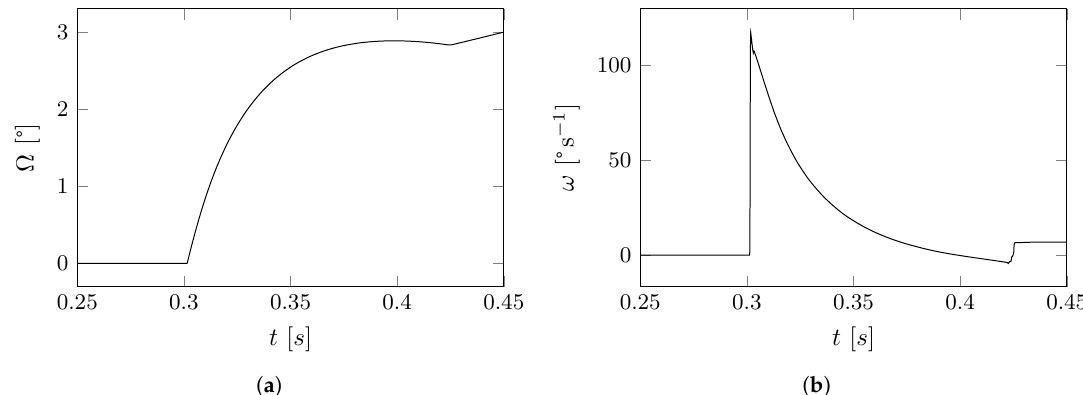
Figure 15. ( a ) The lander structure center mass rotation around its vertical axis and ( b ) its angular speed around the same